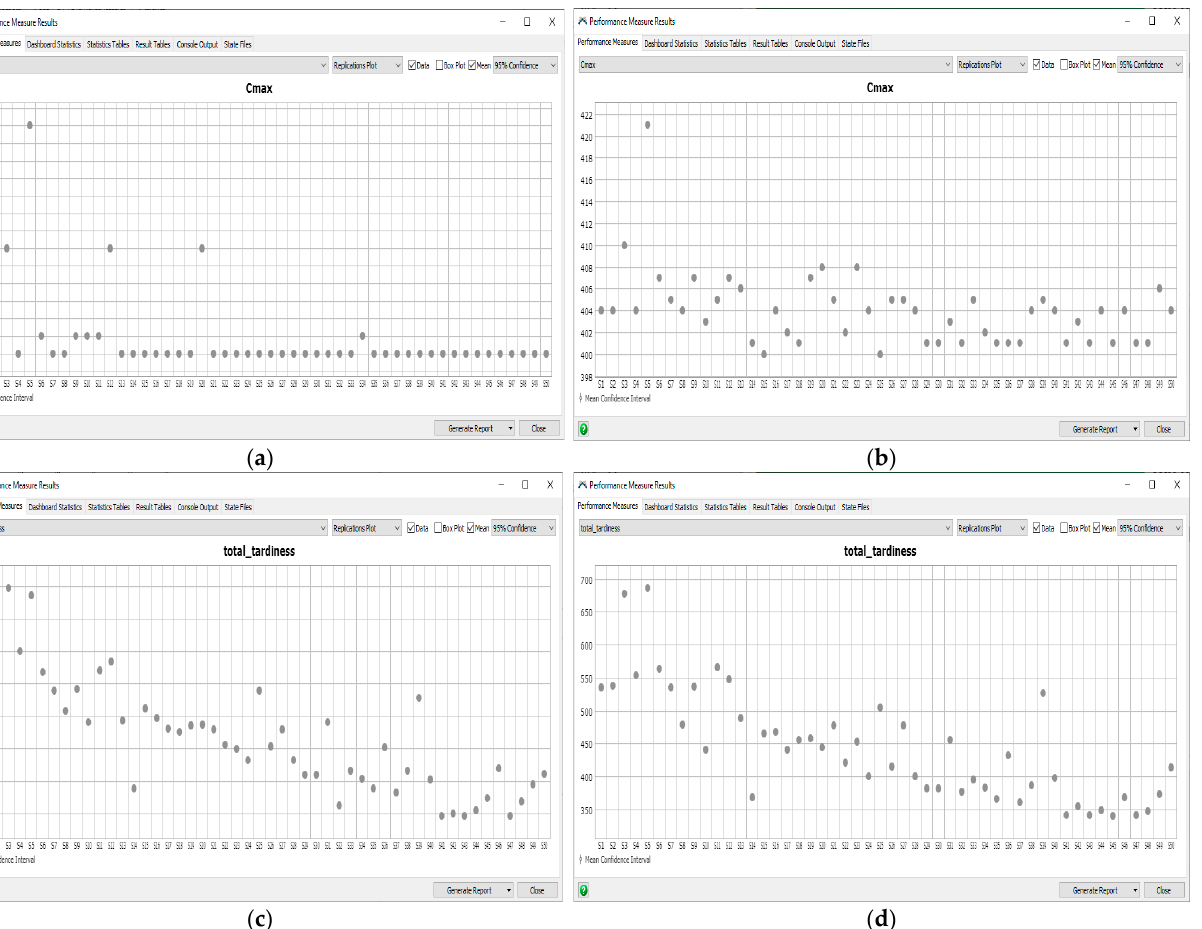
Figure 9. Cmax ( a , b ) and TT ( c , d ) of schedules (schedules S1–S50) without ( a , c ) and with predictive maintenance ( b , d ).